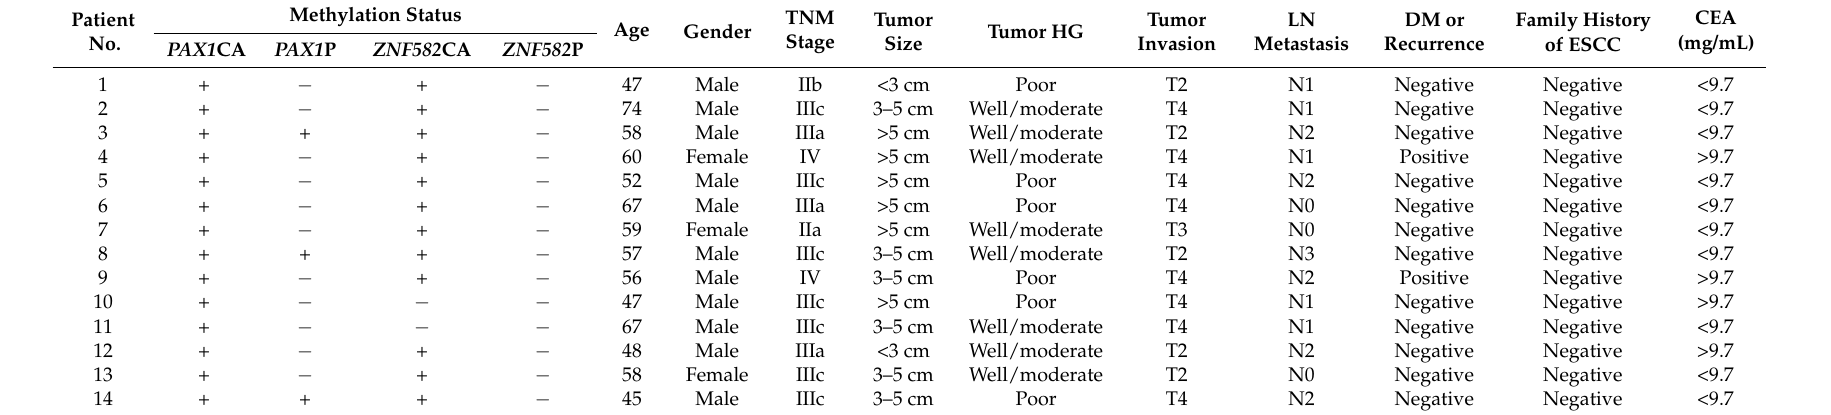
Table 1. ESCC tissues of patients with methylation status of PAX1/ZNF582 genes.